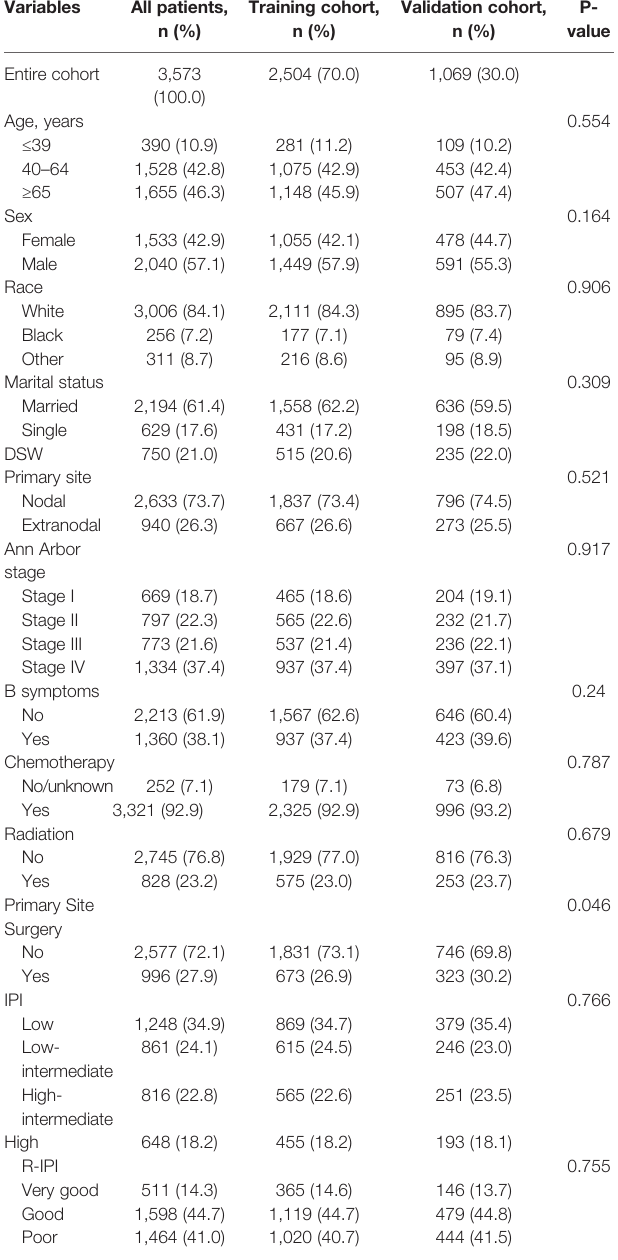
TABLE 1 | Demographic and clinical characteristics of patients in the training and validation cohorts.